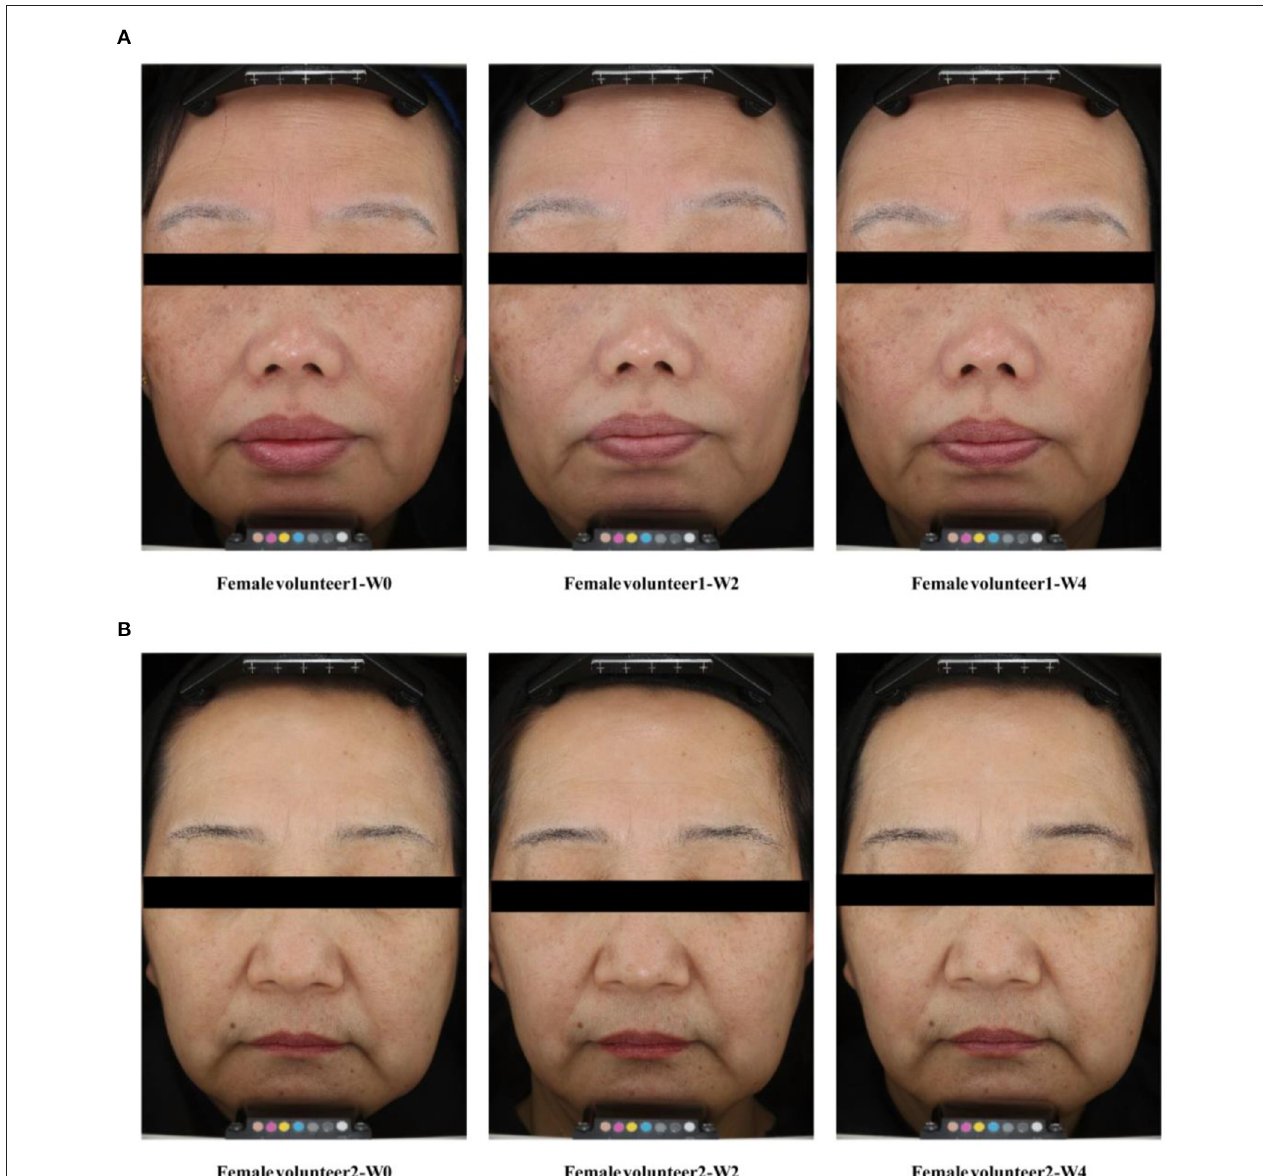
FIGURE 4 | VISIA-CR facial image legend. (A) Case 1: Facial condition of volunteer 1 at 0, 2, and 4 weeks; (B) Case 2: Facial condition of volunteer 2 at 0, 2, and 4